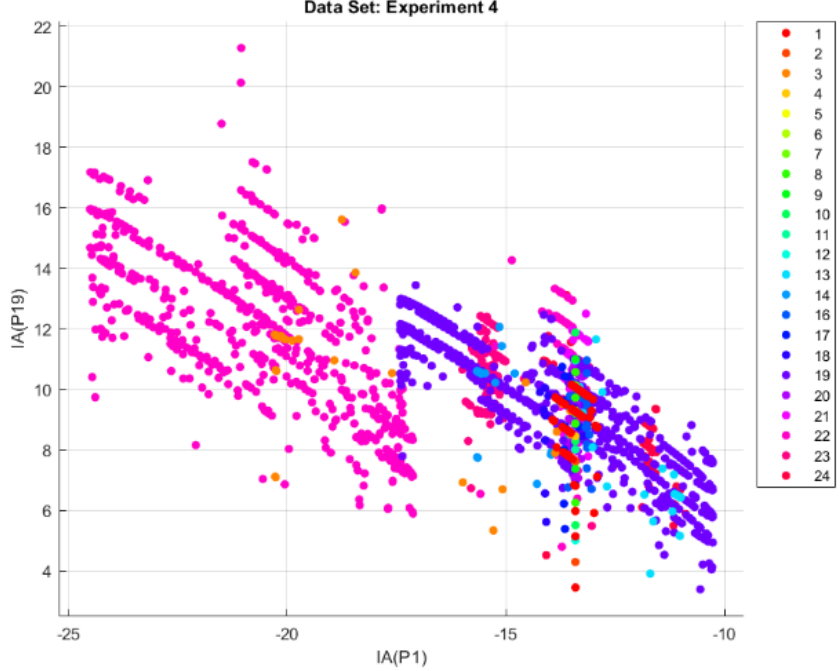
Figure 17. Data set of experiment 4.